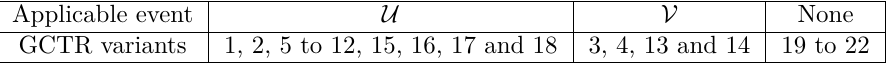
Table 3: Classification of GCTR variants according to their event